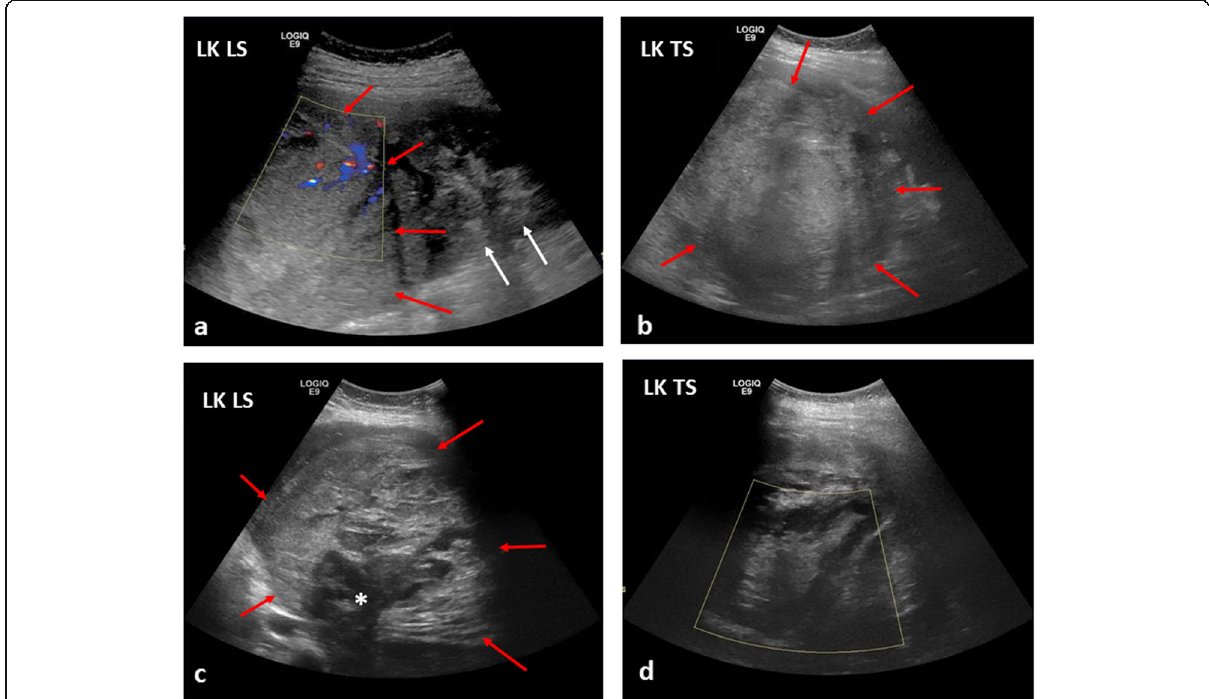
Fig. 19 The same 13-year-old girl as in Fig. 18, with subsequent internal haemorrhoage within a left-sided Wilms ’ tumour. a , b At diagnosis, the initial longitudinal (LS) and transverse (TS) ultrasound images of the left kidney (LK) reveal a large echogenic mass (red arrows) in the upper pole of the kidney, with some preserved renal tissue in the lower pole (white arrows). Some scant internal colour Doppler flow is noted within the mass. c , d A month later, after a sudden drop in the haemoglobin levels accompanied with intense abdominal pain, the ultrasound images of the left kidney reveal a larger, more heterogenous mass (red arrows) with some internal necrosis (white asterisk) and no internal colour Doppler flow in keeping with a large haematoma. It was not possible to clearly delineate the left renal vein at either the initial or subsequent ultrasound